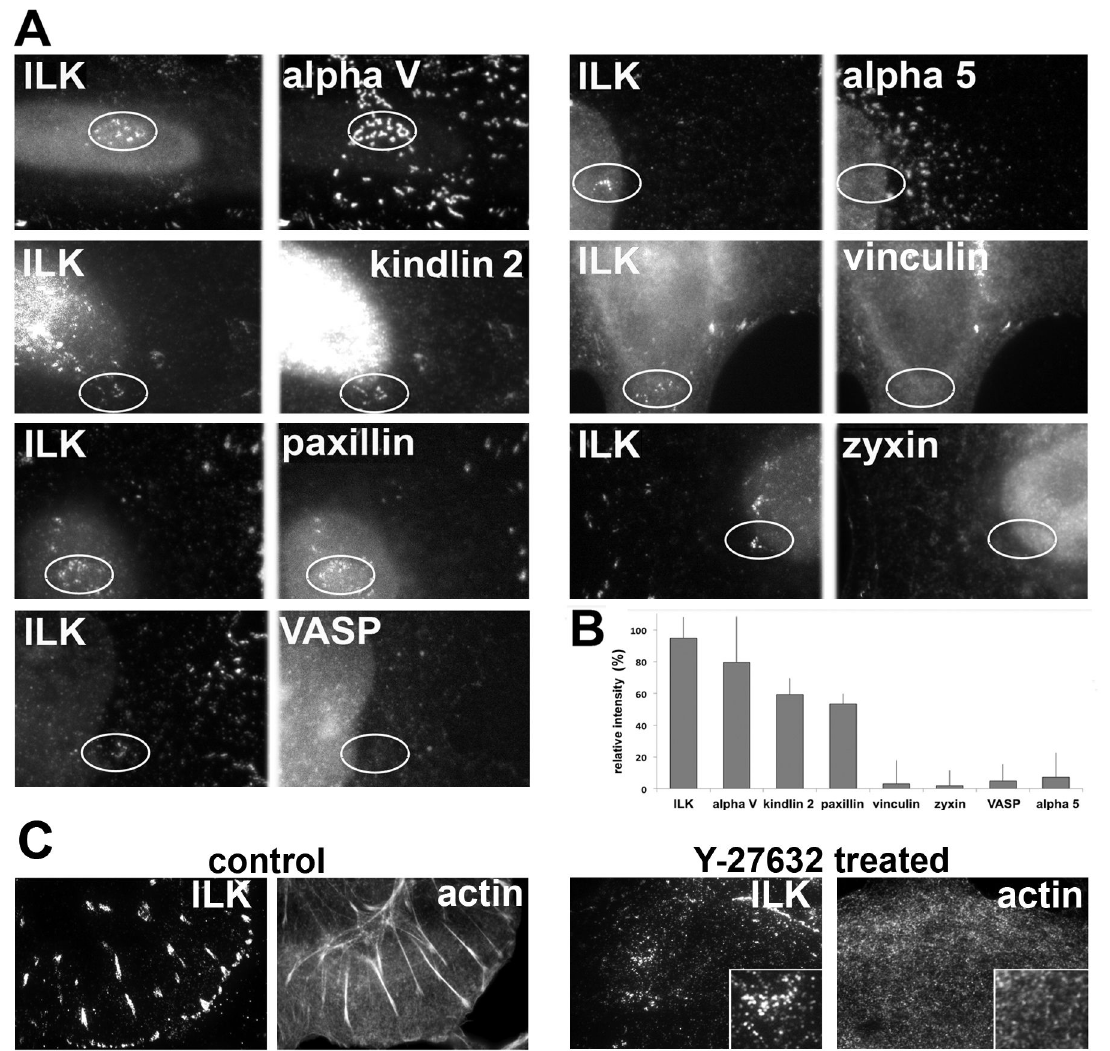
Figure 6. Molecular composition of the novel central adhesions formed following Rho-kinase inhibition. ( A ) HeLa JW cells were treated with 10 µM Y-27632 for 60 min, and double-labeled for ILK, the most prominent component of these adhesions, as well as for additional FA components. The same field is shown for two labeled proteins; circles indicate the region of interest. ( B ) Relative intensity of the novel central adhesions marked by the studied proteins, following 60 min of Y-27632 treatment. The relative intensity was calculated as the percentage of fluorescence intensity measured for the corresponding protein in the untreated FAs. ( C ) Comparison of ILK and actin localization in FAs of untreated cells, and in the central adhesions of Y-27632 treated cells. Two- color TIRF microscopy of the cells prior to (left panel) and following 60 min of Y-27632 treatment (right panel) was used to assess the localization of ILK and actin. No correlation was found between the densities of these two proteins in the central adhesions (see